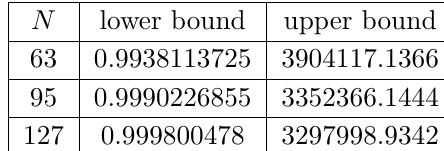
Table 10. Upper and lower bounds on the g -function for stable boundary conditions in c = 24 CFTs with ∆ gap = 4 at various derivative orders N . The lower bounds are insensitive to the assumption of any gap in the boundary spectrum and so rigorously bound the tension of branes in the | Monster | 2 CFT from below, regardless of